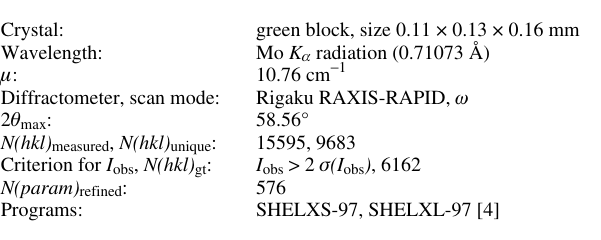
Table 1. Data collection and